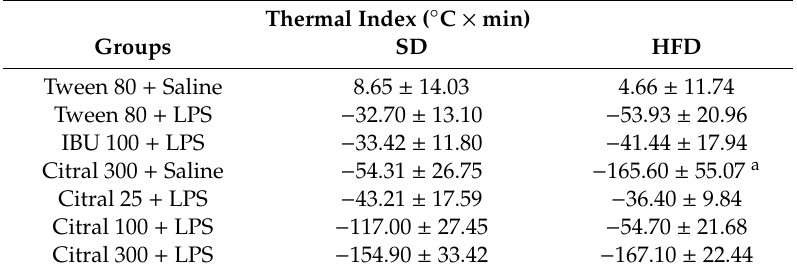
Table 4. Diet e ff ect on the thermal index of animals with di ff erent treatments during LPS-induced Systemic Inflammation